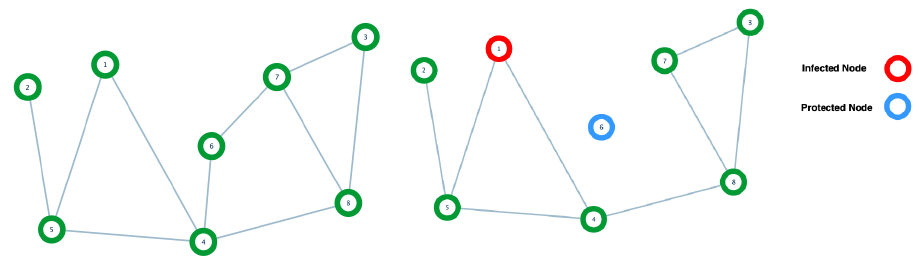
Figure 4. The left side shows a graph without protection or infection. On the right side, we see an infected node (red) and a protected node (blue) in the same